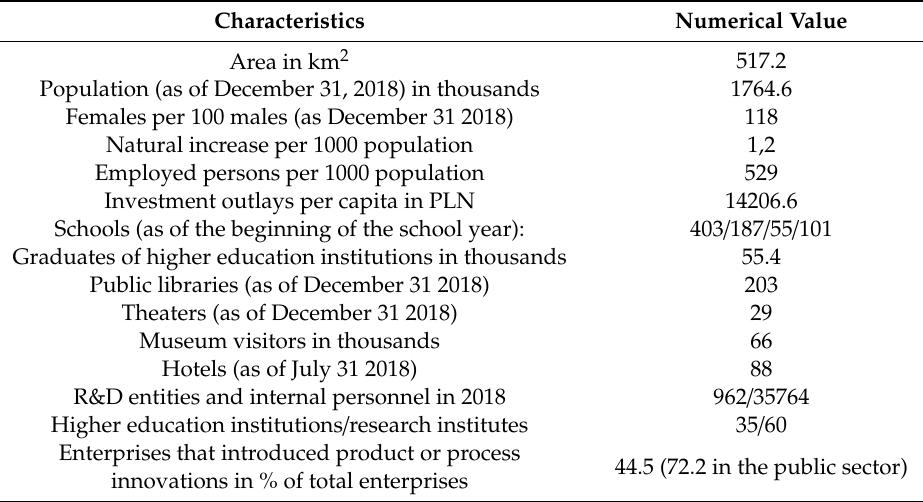
Table 5. Selected characteristics from the “Statistical Yearbook of Warsaw